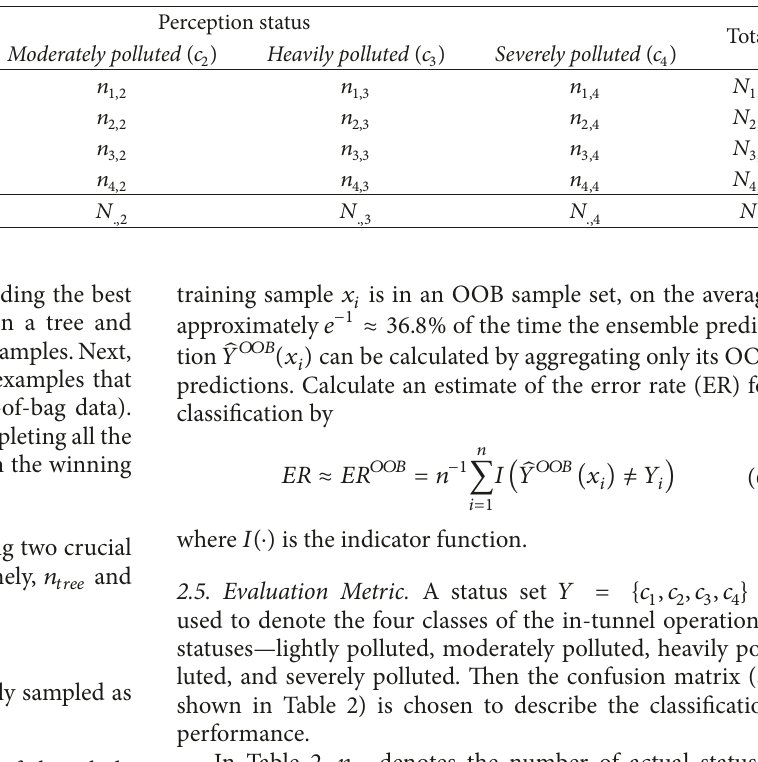
Table 2: Confusion matrix for in-tunnel operational